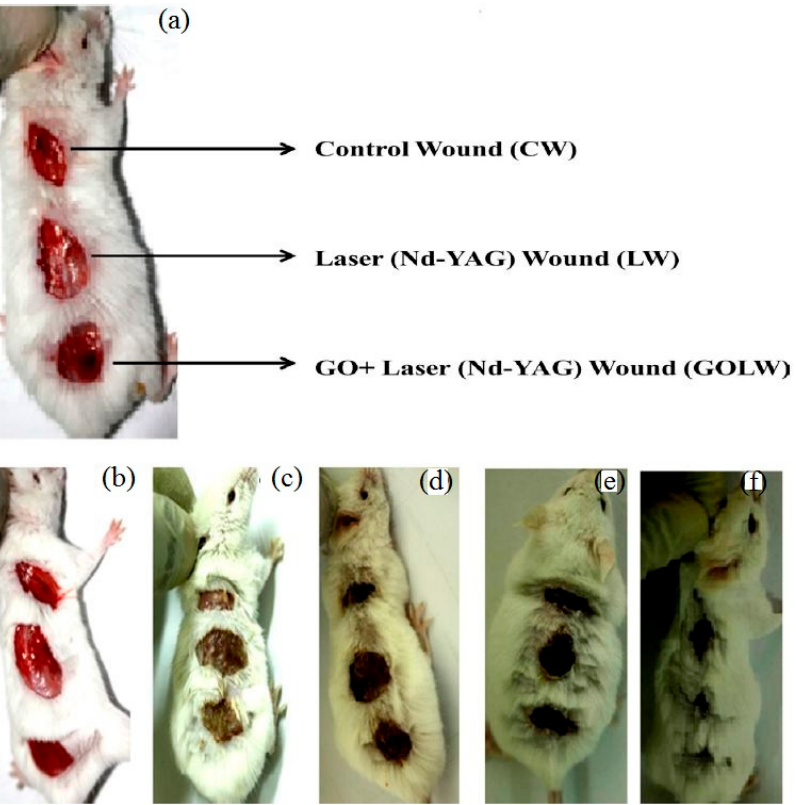
Figure 5. ( a ) Location of wounds, ( b ) fresh wounds on dorsal surface of mice, ( c ) Infection started after 3 days with injection of S. aureus on wounds, ( d,e ) condition of wounds after 6 days of treatment, ( f ) wound treatment on the dorsal surface of mice by using GO and Nd-YAG laser [23].